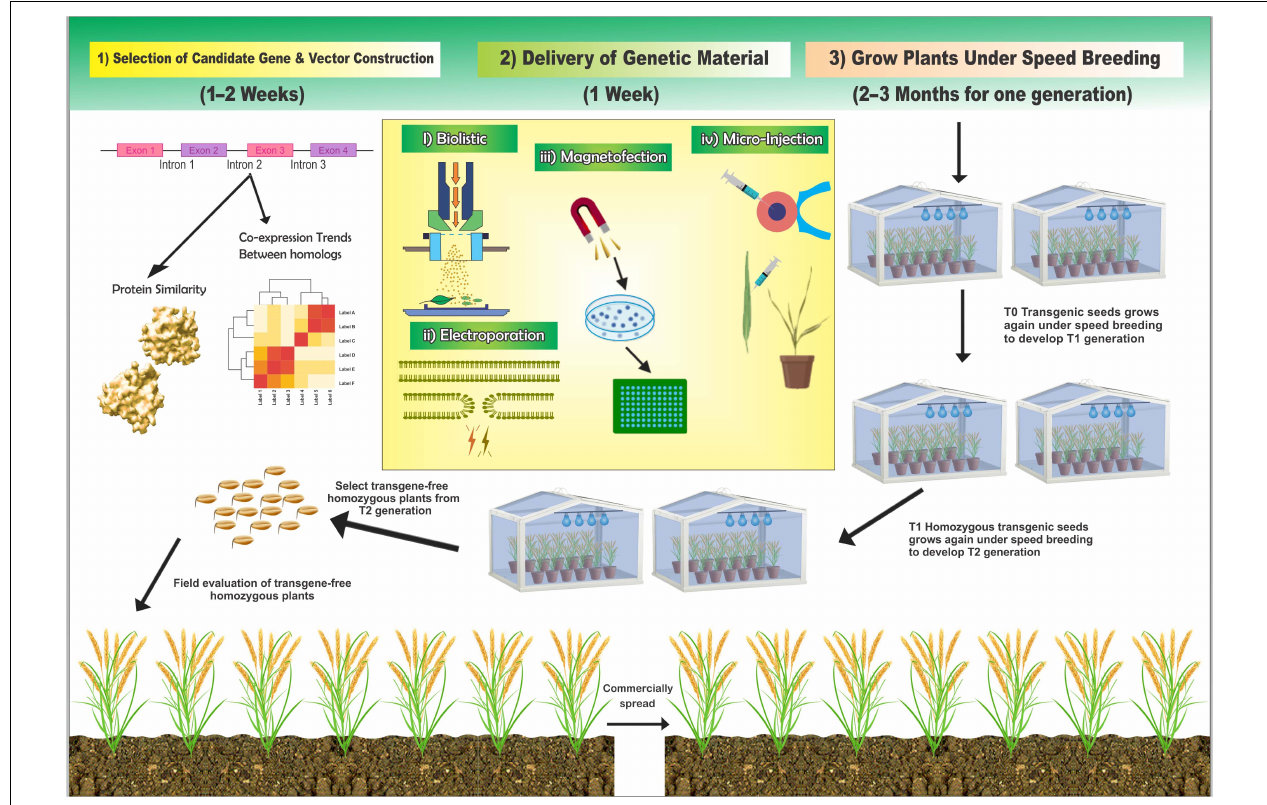
FIGURE 5 | Major steps to efficiently improve the speedy crop process by combining the existing